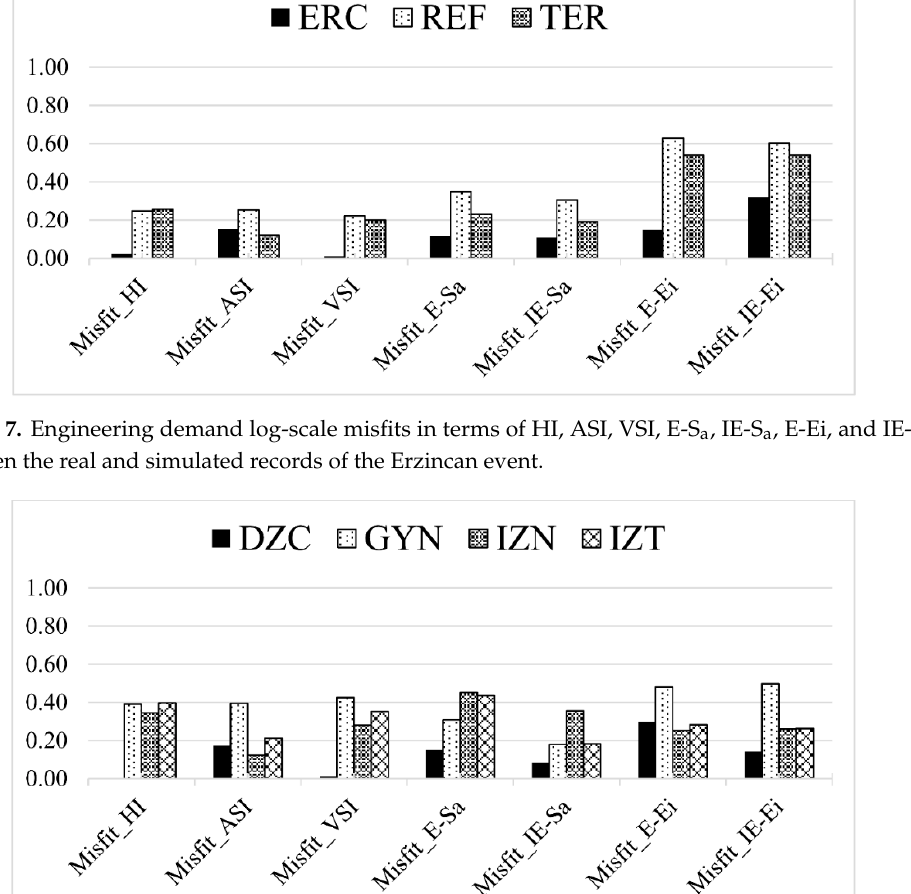
Figure 8. Engineering demand log-scale misfits in terms of HI, ASI, VSI, E-S a , IE-S a , E-Ei, and IE-Ei between the real and simulated records of the Duzce event.